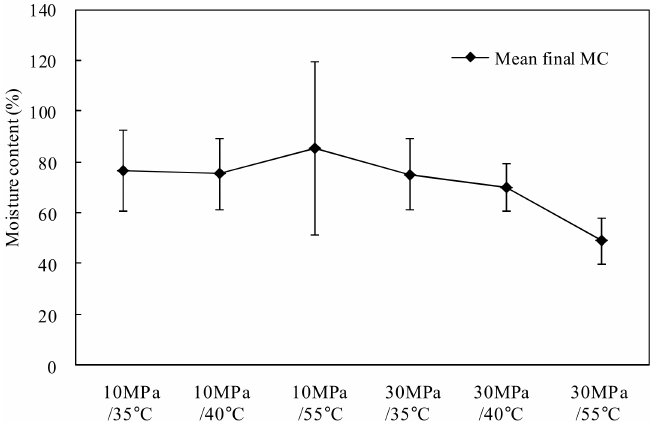
Figure 6. The mean MCs and standard deviations of six conditions after 1 h SuCO 2